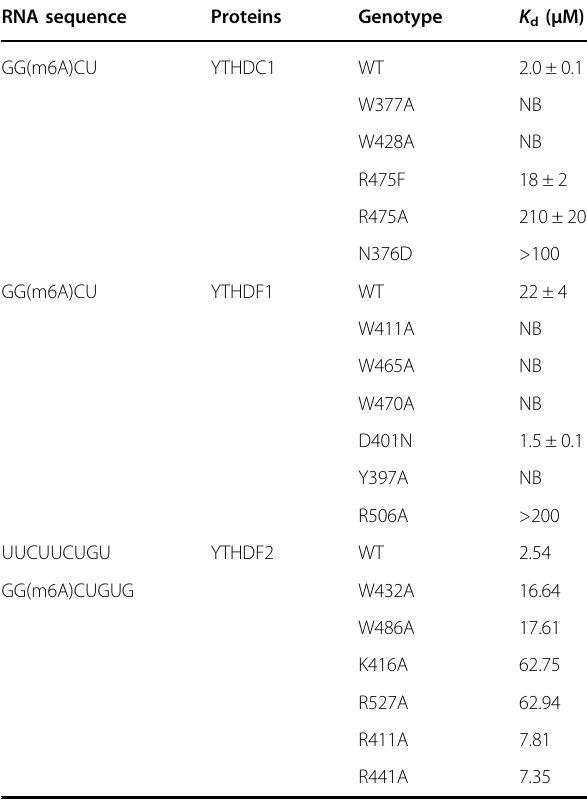
Table 1 Binding af fi nities of the wild-type and mutant YTH domains of YTHDC1, YTHDF1, and YTHDF2 for m6A- modi fi ed RNAs.